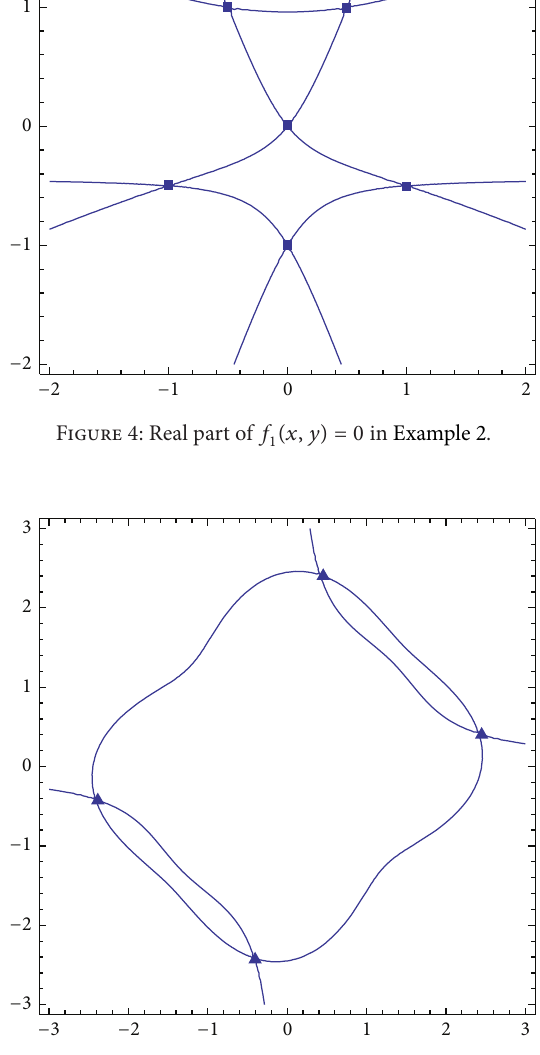
Figure 5: Real part of 𝑓 2 (𝑥, 𝑦) = 0 in Example 2.